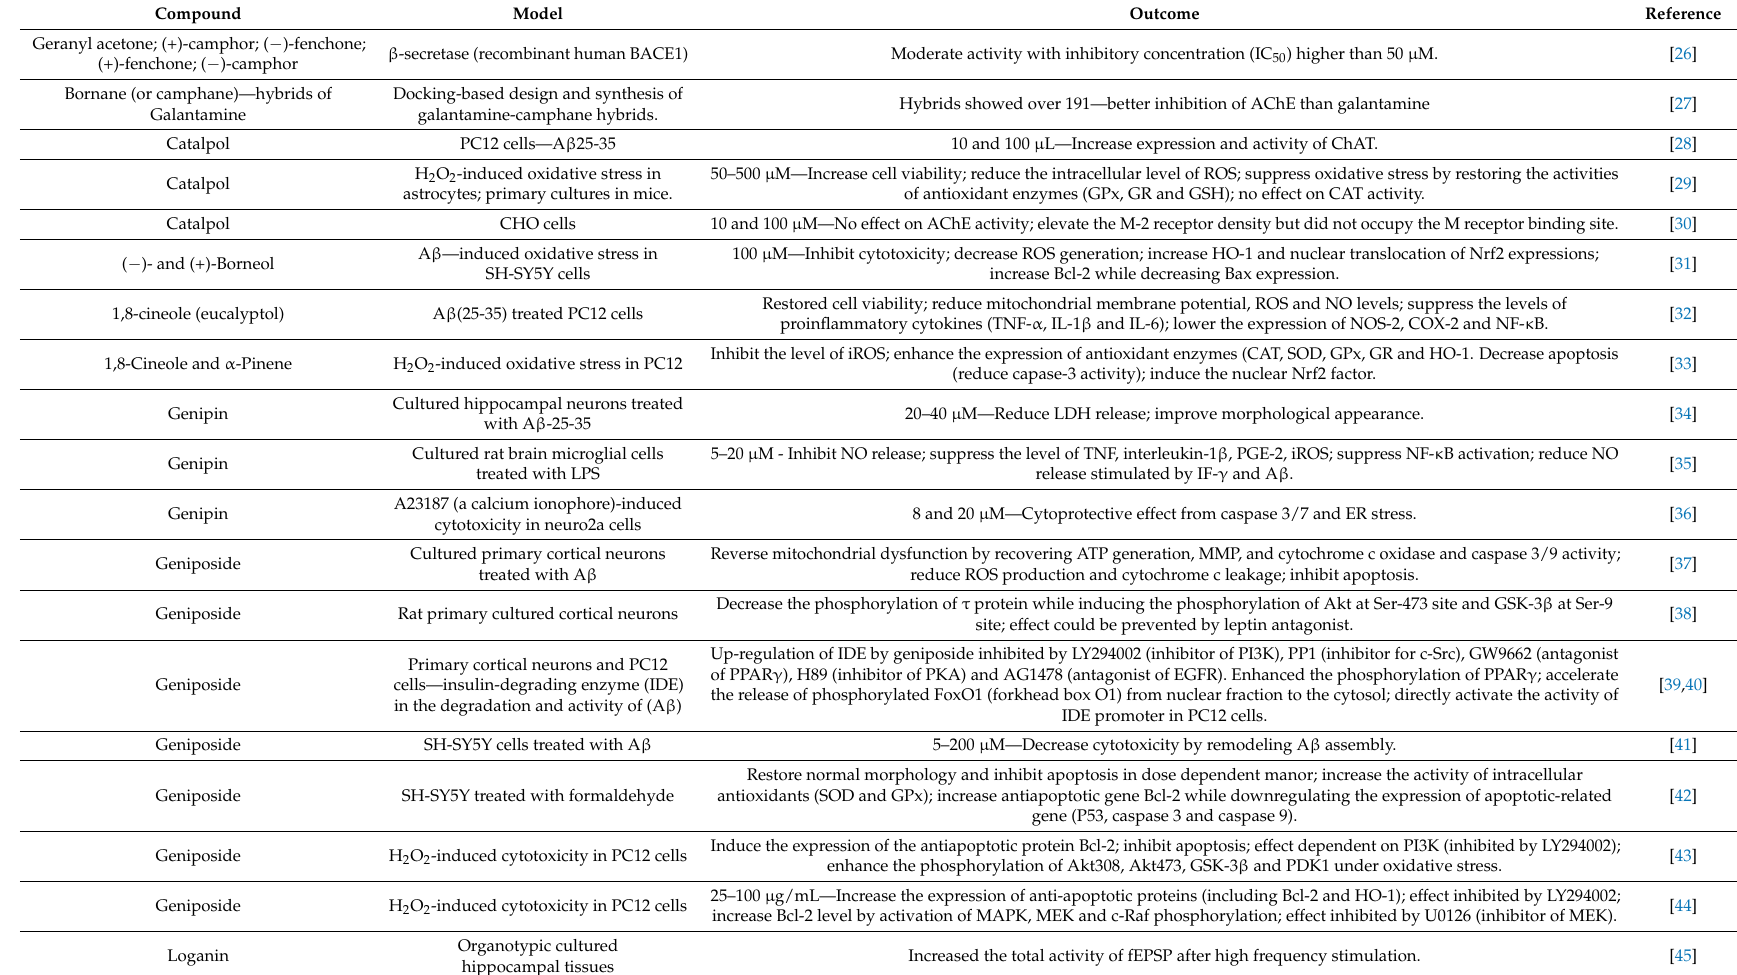
Table 1. In vitro effects of iridoids and other monoterpenes related to AD